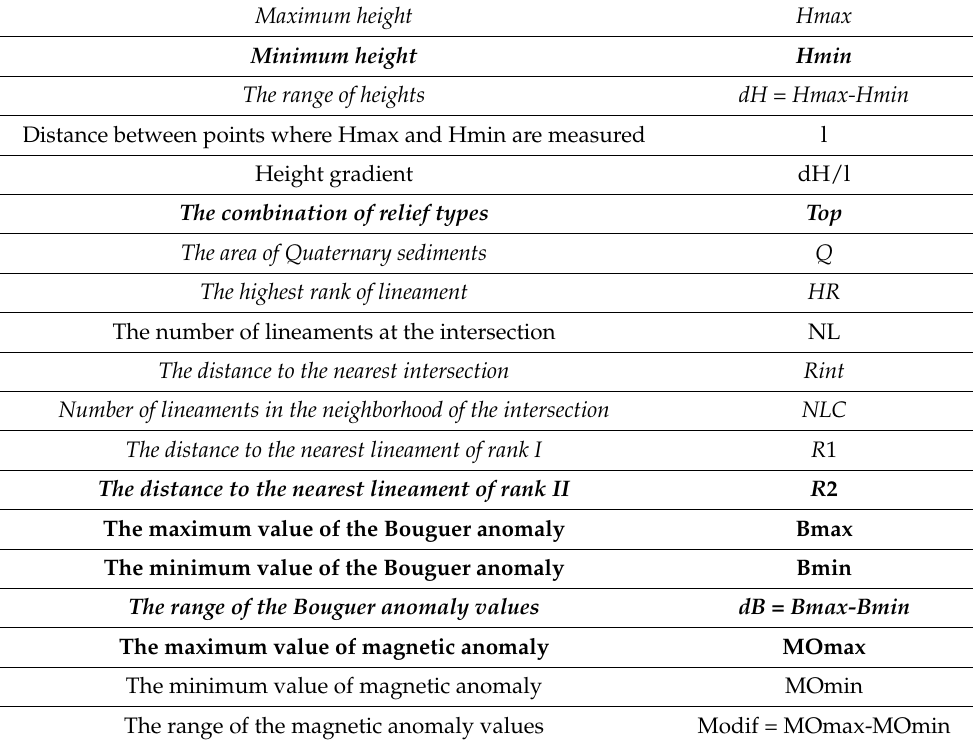
The minimum value of magnetic anomaly The range of the magnetic anomaly